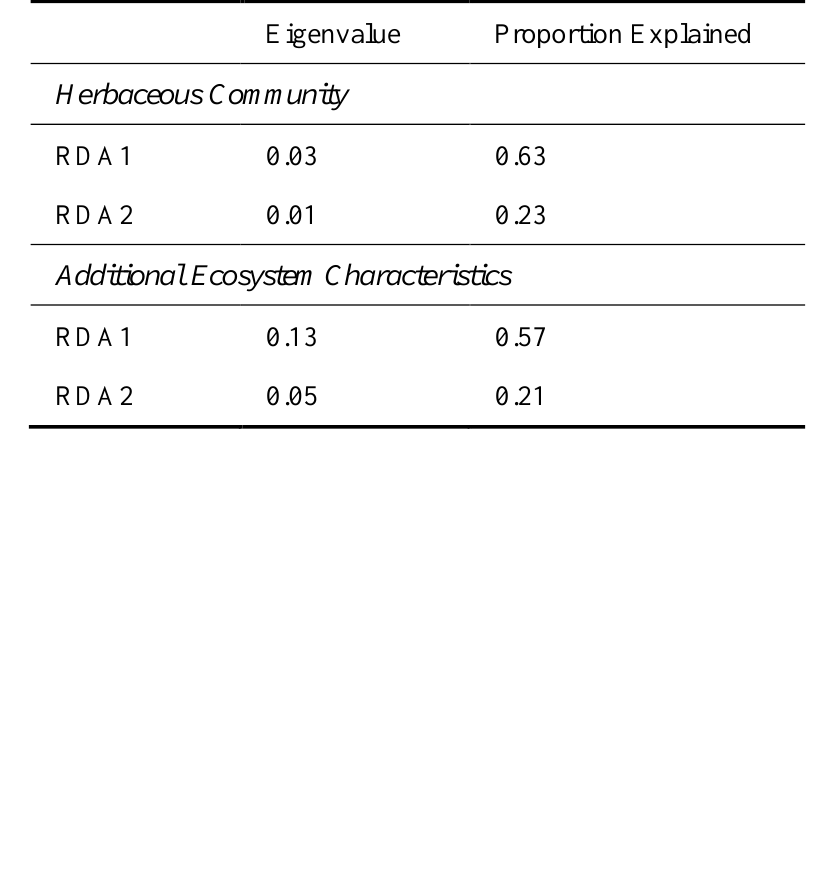
Table A1.1. Eigenvalues and the proportion of explained variation that was represented by RDA1 and RDA2 in two redundancy analyses on community and structural data collected in 2015 and 2016 within and surrounding the perimeter of the 1989 Fort Robinson wildfire, Nebraska, USA across a range of transition classes. Transition classes were used as predictor variables and were composted of fire severity (unburned, low severity, or high severity) and the ecological regime (grassland or forest) that occurred prior to the fire. Italicized titles represent the data used in redundancy analyses, where “Herbaceous Community” indicates RDA outputs with herbaceous plant community data and “Additional Ecosystem Characteristics” indicates RDA outputs with understory woody plant height and cover, bird species presence, coarse woody debris cover, and snag